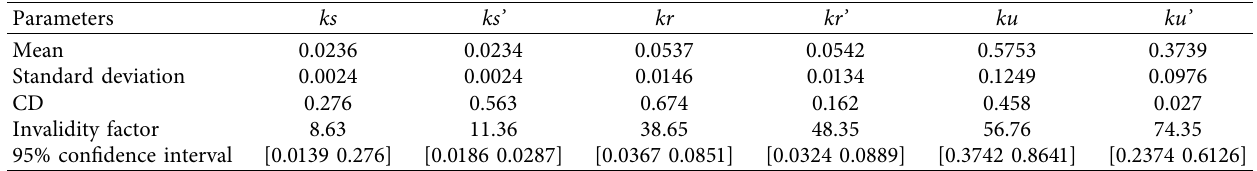
Table 3: Parameter estimation of EM.